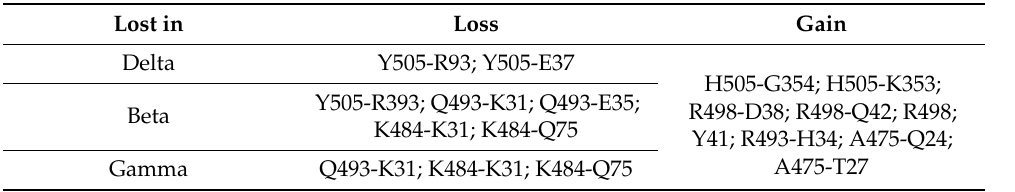
Table 4. Hydrogen bond interaction loss and gain between ACE2 and RBD of Omicron spike protein compared to other